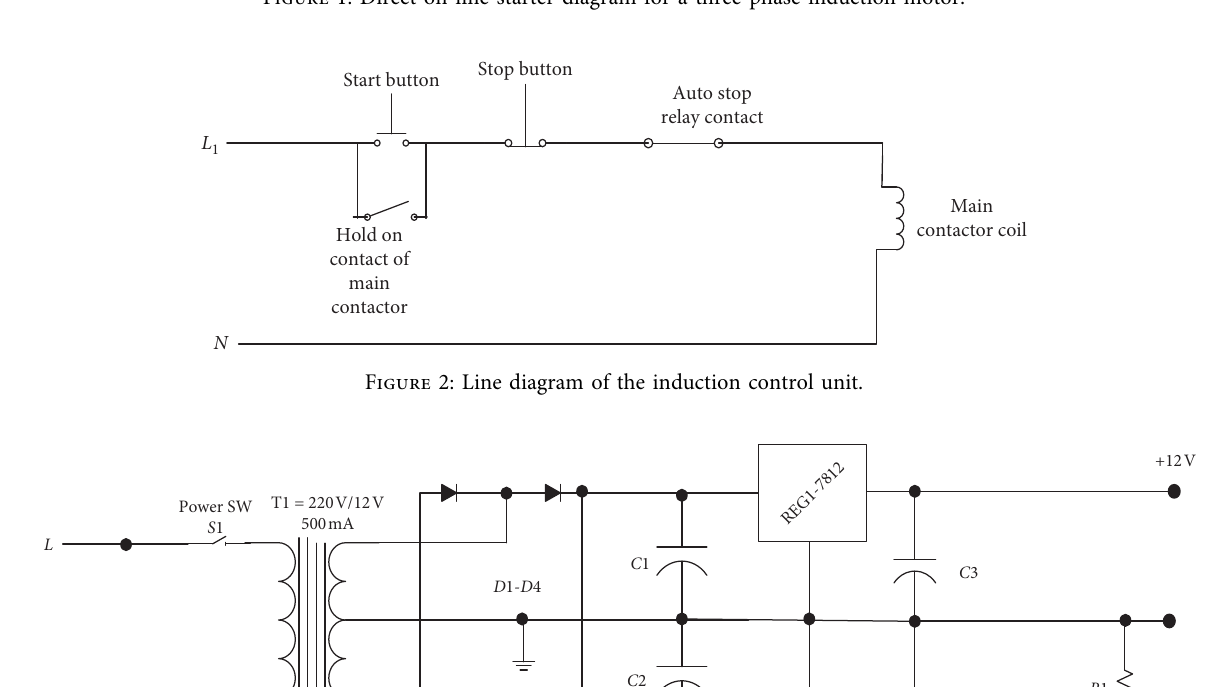
Figure 1: Direct on-line starter diagram for a three-phase induction motor.